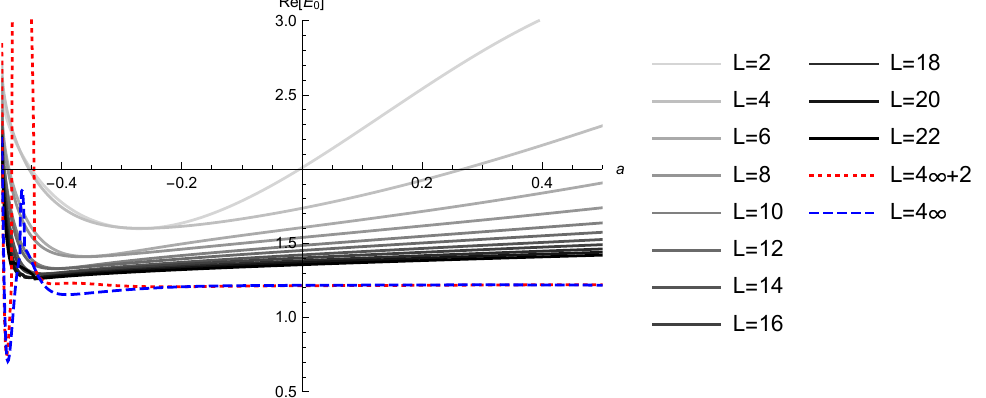
Figure 3 . Plots of the imaginary part of the energy E (2.15) for the “double brane” solution Φ D at the truncation level L . The dotted and dashed lines are extrapolations to L = 4 k + 2 ( k → ∞ ) and L = 4 k ( k → ∞ ), respectively. The horizontal axis denotes the value of the parameter a .